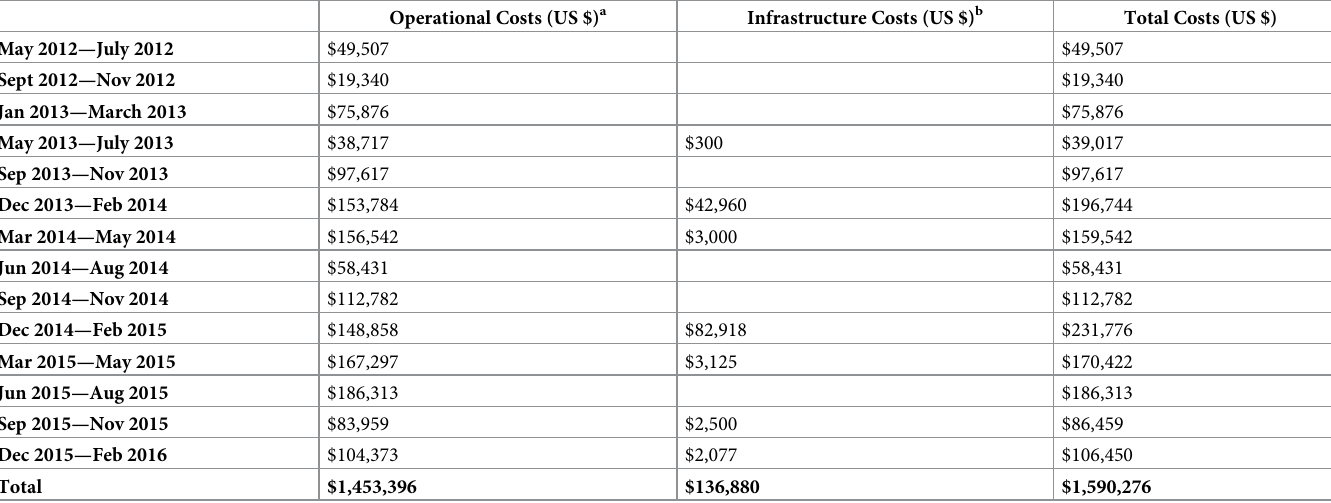
Table 3. Reported operational and infrastructure program costs in US